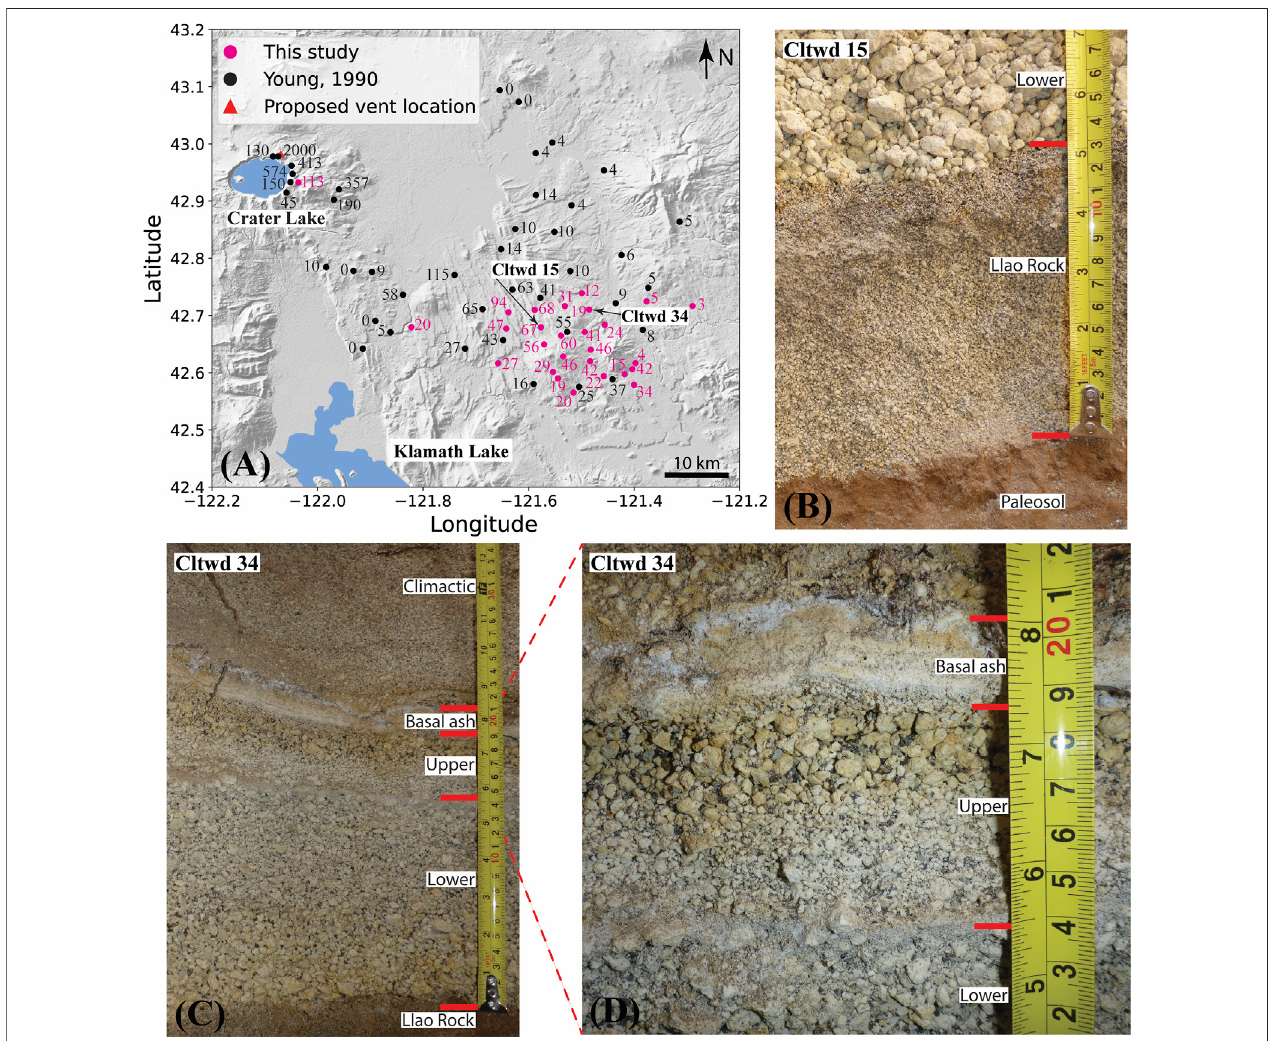
FIGURE 1 | (A) Location of collected samples with total Cleetwood eruption thicknesses (cm) from this study, in pink, and Young (1990), in black. Proposed vent location from Bacon (1983) and background is global Earth relief (Tozer et al., 2019). (B) Photograph showing all of Llao Rock and the contact between Llao Rock and lower Cleetwood at location Cltwd 15. Note the drastic increase in size of pyroclasts from Llao Rock to lower Cleetwood. (C) Stratigraphic sequence showing lower Cleetwood, upper Cleetwood, and the overlying Climactic deposit at location Cltwd 34. Llao Rock is not present at this location. (D) Closeup photograph showing the end of lower Cleetwood, upper Cleetwood, and the Basal ash layer, which marks the beginning of the Climactic deposit (Young, 1990). Note the gray fi ne ash layer de fi ning the boundary between lower Cleetwood and upper Cleetwood. Measuring tape is in both inches (left) and centimeters (right).